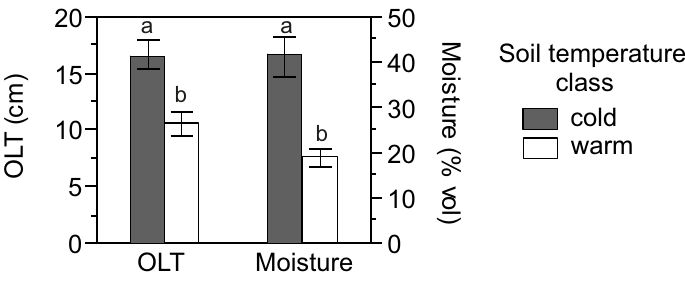
Figure 4. Mean ± SE organic layer thickness (OLT) and soil moisture by soil temperature class. Significant differences between cold ( ≤ 1.0 ◦ C, n = 13) and warm ( ≥ 2.5 ◦ C, n = 17) groups were determined with two-tailed t-tests and denoted by